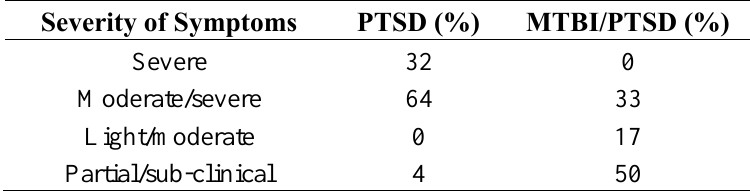
Table 3. Percentage of the PTSD group according to the severity of